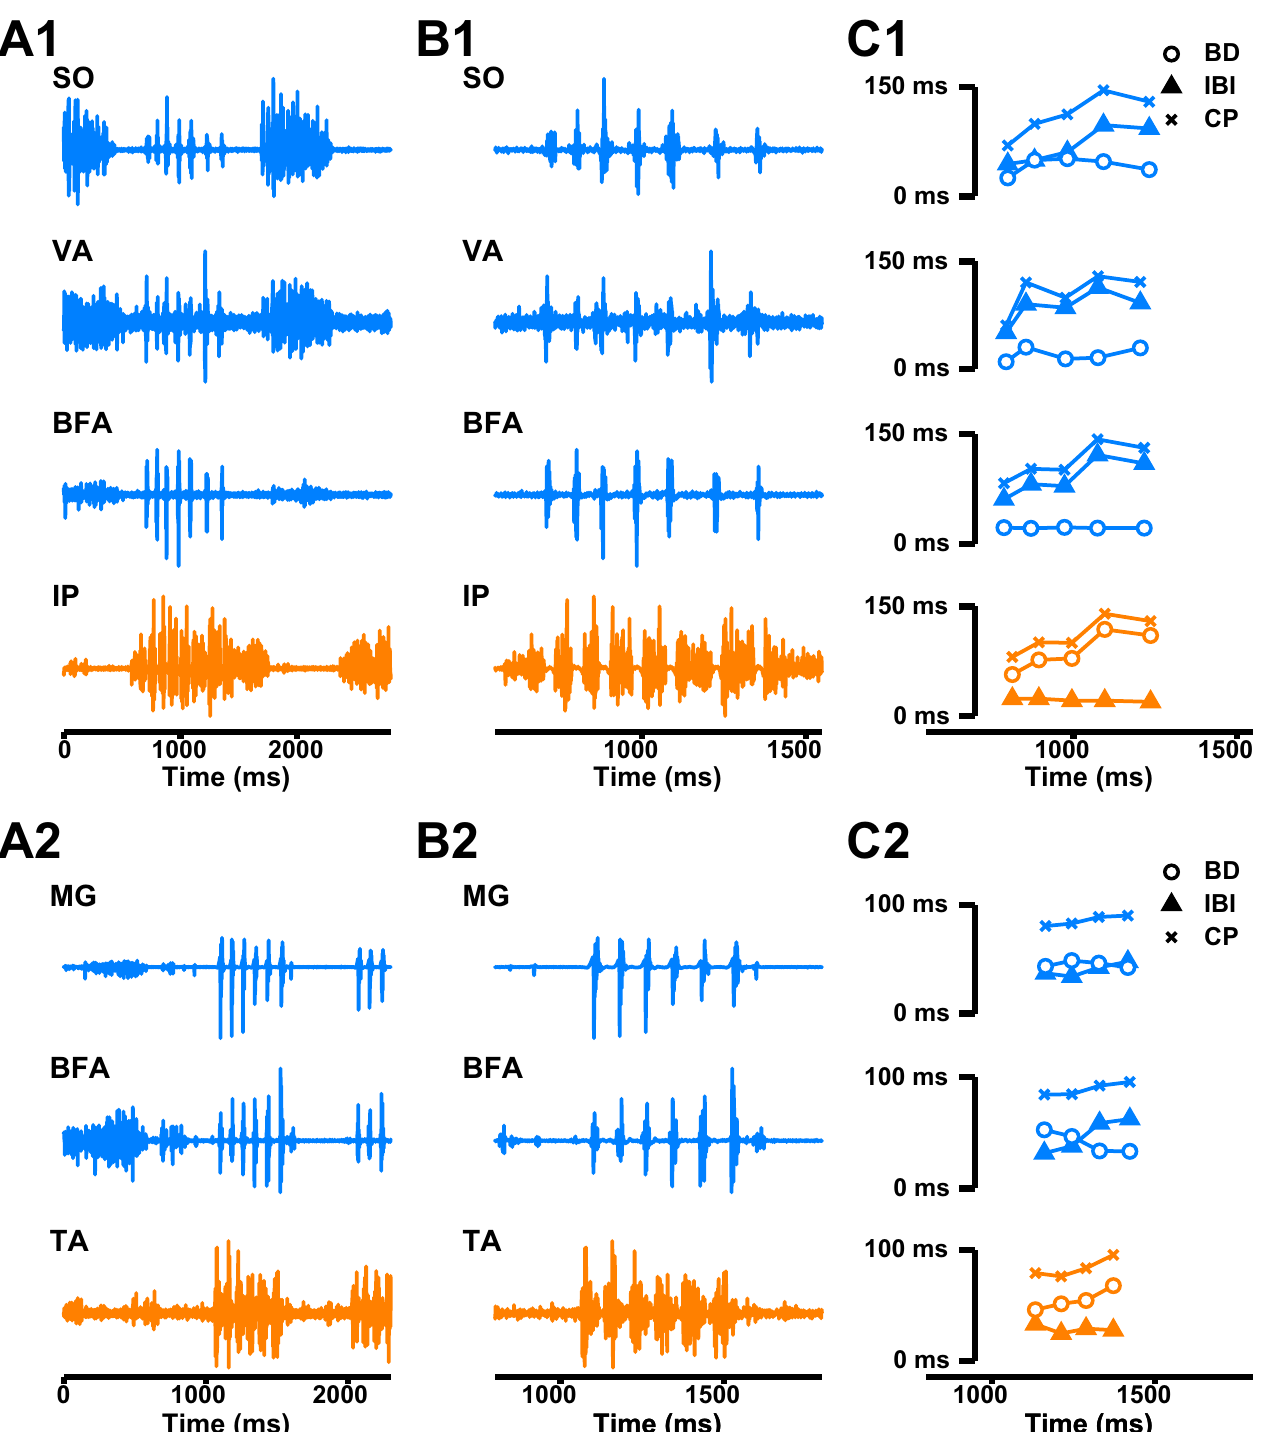
Fig 9. Examples of EMG extensor and flexor activity of hindlimb muscles in a paw-shake episode during locomotion. Data of Cats J and F (Table 3). Paw- shake EMG activity during locomotion is shown for muscles with extensor EMG bursts ( medial gastrocnemius , MG; soleus , SO; vastus lateralis , VA; and biceps femoris anterior , BFA) and flexor EMG bursts ( iliopsoas , IP and tibialis anterior , TA). (A1) EMG activity of muscles SO, VA, BFA and IP of cat J during walking and a paw-shake response. (A2) EMG activity of muscles MG, SO, and TA of cat F during walking and a paw-shake response. (B1, B2) Zoomed-in EMG traces of the paw-shake episodes in A1 and A2 . (C1, C2) Burst duration (BD), interburst interval (IBI), and cycle period (CP) for each cycle of the paw- shake responses and each muscle as a function of time. The activities of extensors and flexors are depicted in blue and orange,